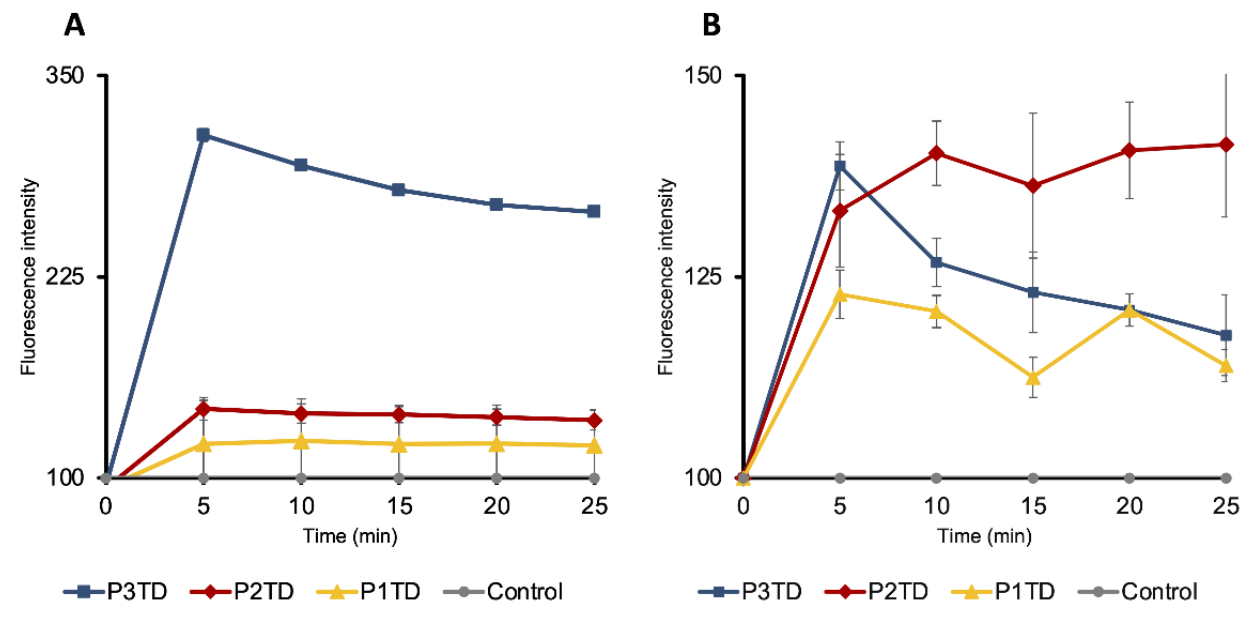
Figure 10. Cell membrane permeability of E. coli by cationic polymers P1TD, P2TD and P3TD: ( A ) Outer-membrane by the increase in NPN fluorescence; ( B ) Inner-membrane by the increase in PI fluorescence. Standard deviation is plotted with error bars in the graphs. Polymer concentration was 0.5 mg/mL.